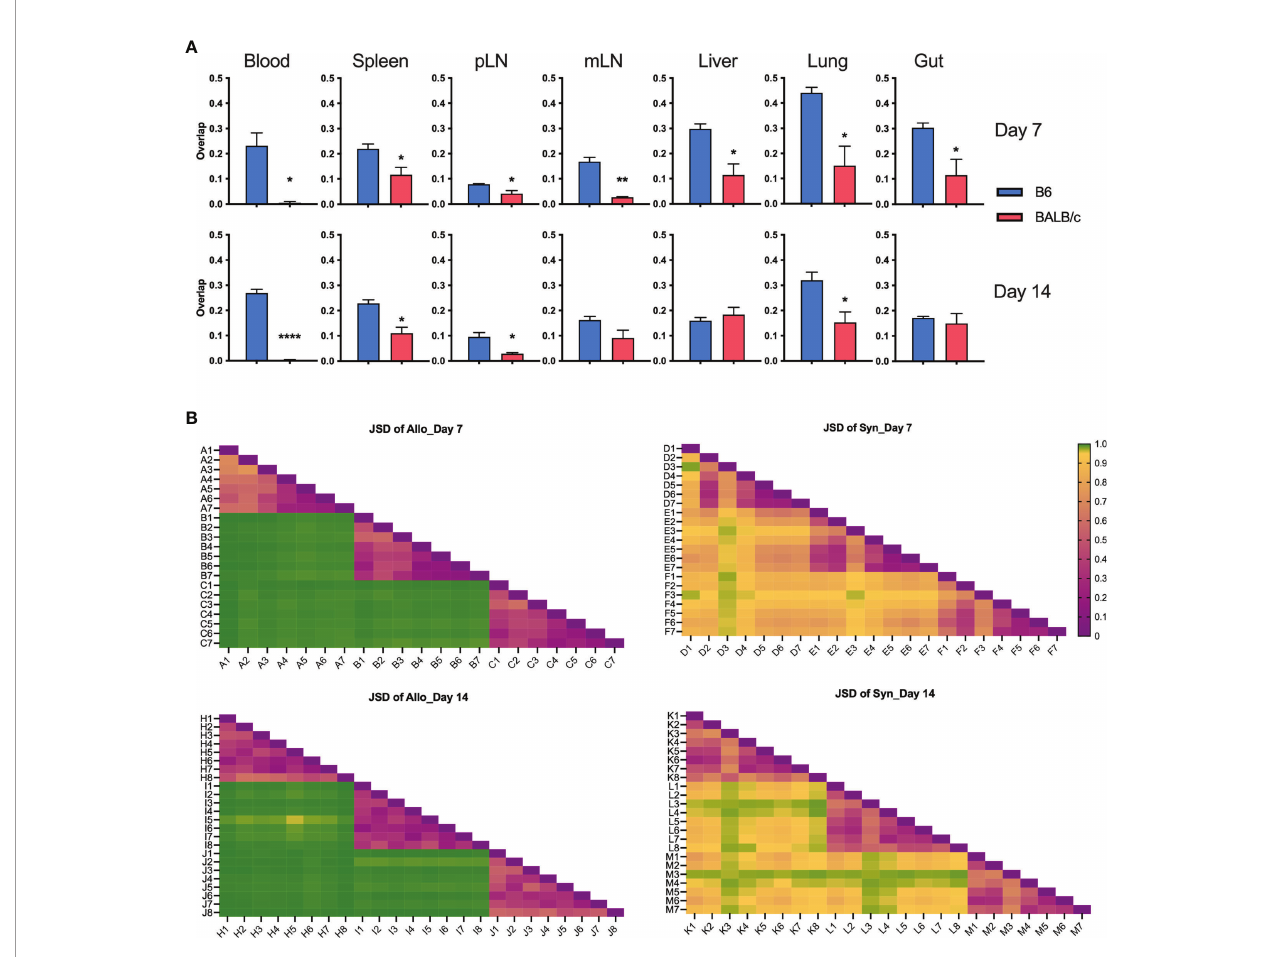
FIGURE 5 | T-cell clone sharing between recipients after BMT. Bar graph shows overlap metric of T-cell clones among replicate mice (A) . To measure repertoire similarity, which accounts for the frequencies of shared clones, Jensen-Shannon Divergence (JSD) was computed by summing entropy(x) + entropy(y) divided by entropy of the summed vector x + y. x: Vector of clone counts or normalized frequencies for a given sample; y: Vector of clone counts or normalized frequencies for a given sample. Scales are from 0 to 1, where 0 indicates identical repertoires with identical clone frequencies and 1 indicates no shared clones. JSD data were pooled in heatmaps (B) . 1 — blood, 2 — spleen, 3 — pLN, 4 — mLN, 5 — liver, 6 — lung, 7 — gut, 8 — skin; capital letter represents mouse ID. *p < 0.05, **p < 0.01, ****p <